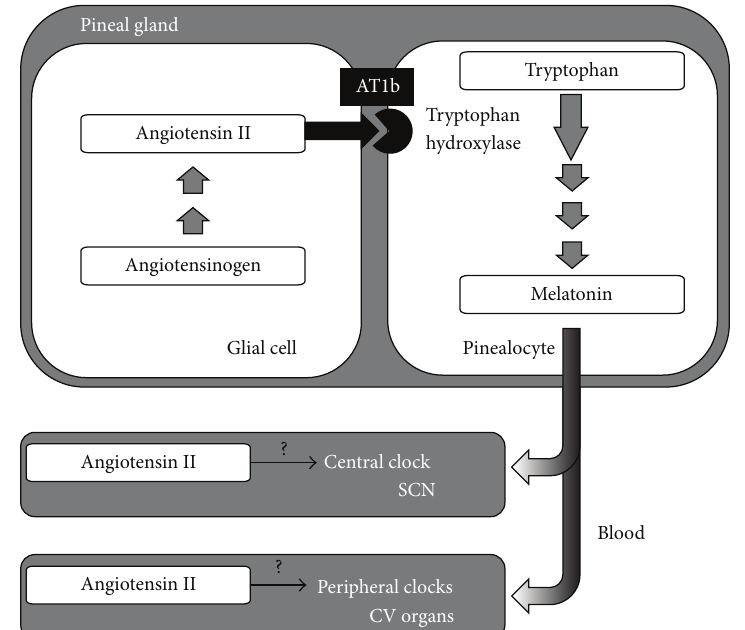
F 1: Pineal renin-angiotensin system (RAS) interacts with melatonin synthesis. Angiotensin II, produced from angiotensinogen produced by glial cells, acts on AT1b receptors present on pinealocytes to stimulate tryptophan hydroxylase, which is the rate-limiting enzyme